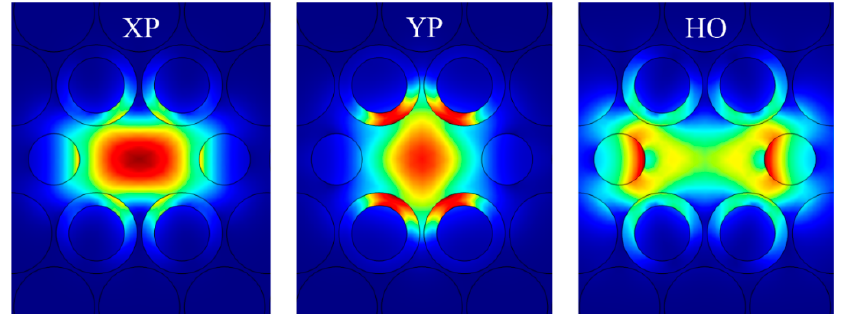
Figure 2. Simulated distributions of the magnitude of the total electric field of the X-polarized (XP) and Y-polarized (YP) modes and the lowest loss higher-order (HO) mode of the passive ENZ-based PCF at 1.0 THz.